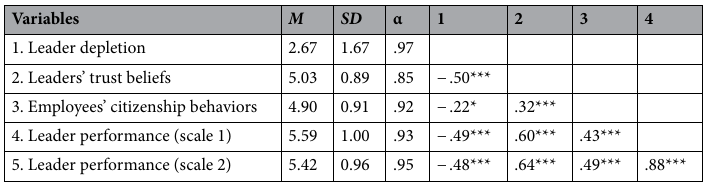
Table 1. Means, standard deviations, and intercorrelations (Study 1). * p < .05. ** p < .01. *** p < .001.